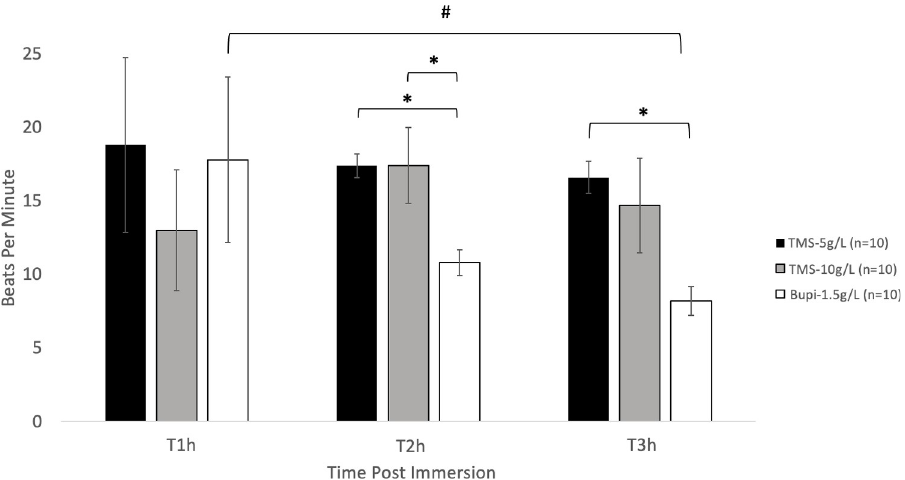
Fig 2. Heart rate after 1-h immersion. Heart rate (bpm; mean ± SEM) detected audibly via doppler ultrasound flow evaluation. � values are significantly different ( P < 0.05) from each other. # values are significantly different ( P < 0.05) between time